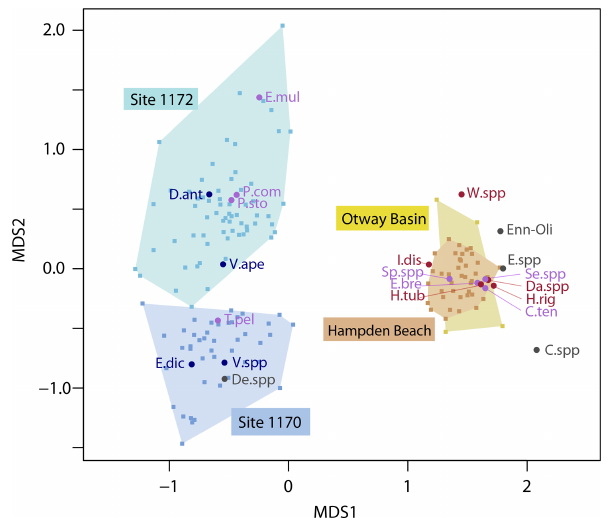
Figure 5. Nonmetric multidimensional scaling ordination diagram for the combined dinocyst assemblage data of Site 1170, Site 1172, Hampden Beach, and Otway Basin. Species scores as circles, color- coded by biogeographic affinity (red, mid-/low-latitude; purple, cosmopolitan; blue, endemic; gray, not assigned). Samples scores as squares, color-coded by location (light blue, Site 1170; dark blue, Site 1172; orange, Hampden Beach; yellow, Otway Basin), with shading connecting same-location samples. Abbreviations are as follows: C.spp, Corrudinium spp. (pars); C.ten, Cribroperi- dinium tenuitabulatum ; Da.spp, Dapsilidinium spp.; D.ant, Deflan- drea antarctica ; De.spp, Deflandrea spp.; E.bre, Elytrocysta brevis ; E.dic, Enneadocysta dictyostila ; E.mul, Enneadocysta multicor- nuta ; Enn-Oli, Enneadocysta-Oligosphaeridium intermediate; E. spp, Enneadocysta spp. (pars); H.rig, Hystrichokolpoma rigaudiae ; H.tub, Hystrichosphaeridium tubiferum ; I.dis, Impagidinium dis- pertitum ; P.com, Phthanoperidinium comatum ; P.sto, Phthanoperi- dinium stockmansii ; Se.spp, Senegalinium spp. (pars); Sp.spp, Spiniferites spp. (pars); T.pel, Thalassiphora pelagica ; V.ape, Voz- zhennikovia apertura ; V.spp, Vozzhennikovia spp. (pars); W.spp, wetzelielloids. For visual clarity, only the most abundant taxa are